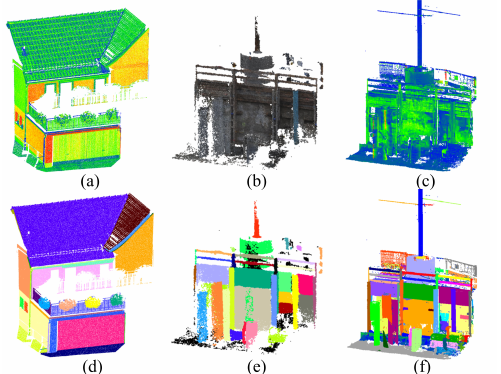
Figure 6. (a)-(c) Sample point clouds. (d)-(f) Corresponding manually segmented ground truth.